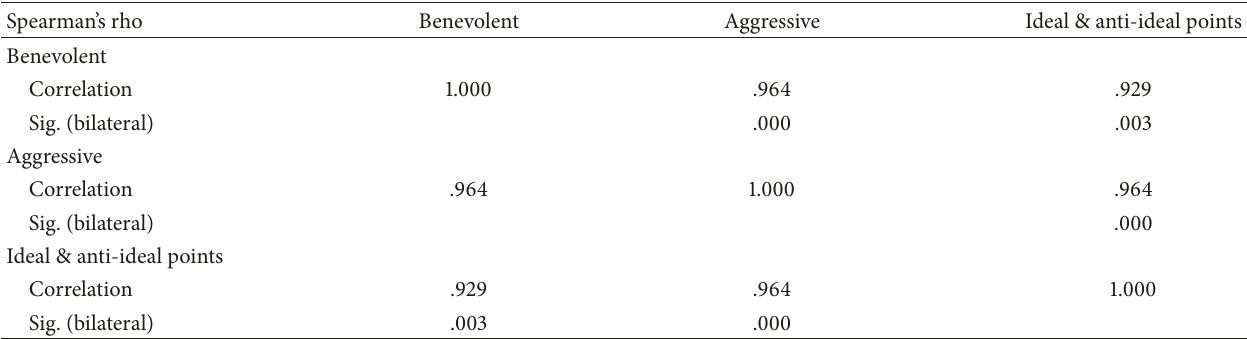
Table 3: DEA efficiency correlation